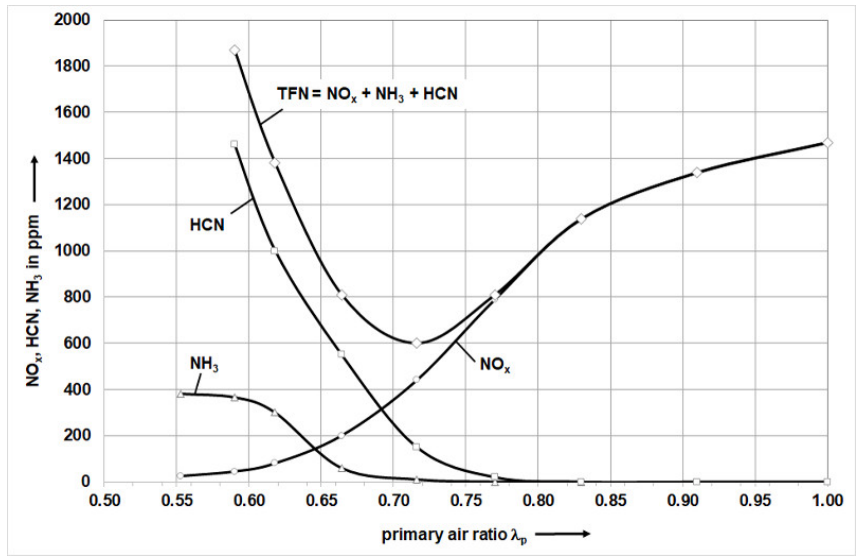
Figure 2. TFN in dependency of the air ratio λ [11].